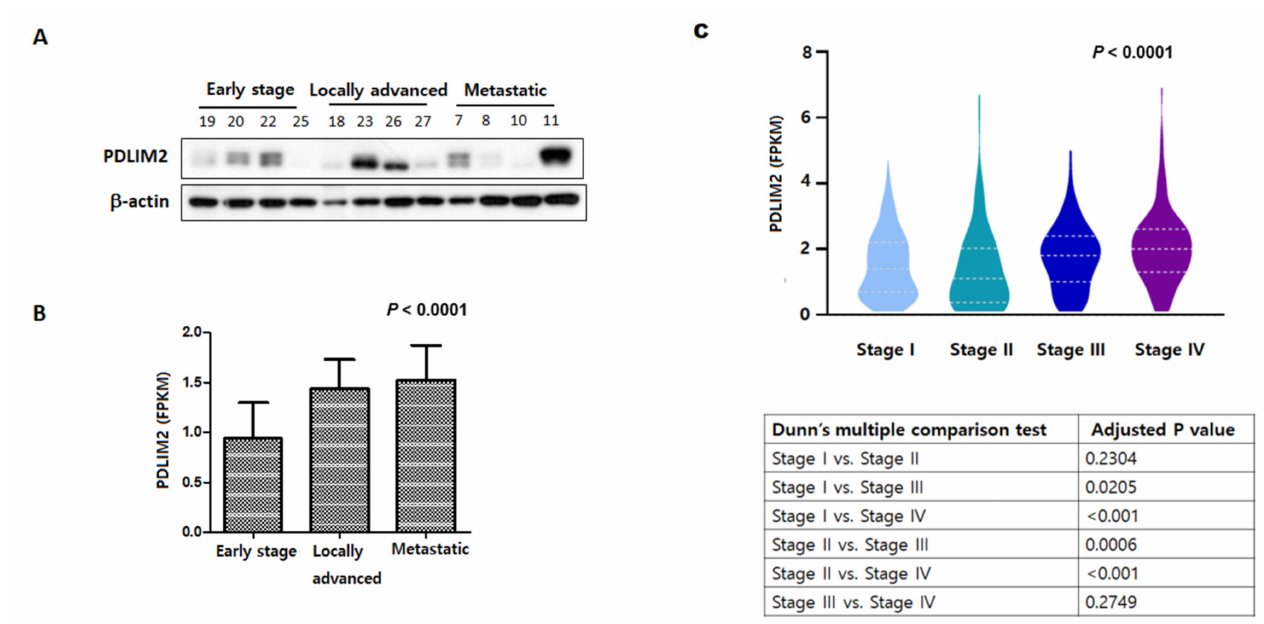
Figure 1. Expression of PDLIM2 gene in human kidney cancer cell. ( A ) PDLIM2 protein expression in various renal cancer cells. Whole cell lysates were analyzed using the indicated antibodies. ( B ) The mRNA levels of various renal cancer cells. Total RNAs from each cell line were measured using RT-qPCR. ( C ) The results of the mRNA sequencing data of TCGA-RCC and